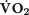
Dependence of total oxygen consumption (V˙O2), V˙O2 related to proton leak, V˙O2 related to ATP synthesis, Δp and NADH (% of total NAD) and phenomenological ATP/O2 ratio on relative activity of ATP usage (relative rate constant, kUT, or its activation in relation to rest, AUT) in skeletal muscle for proton leak activity (rate constant) set to zero (no proton leak).